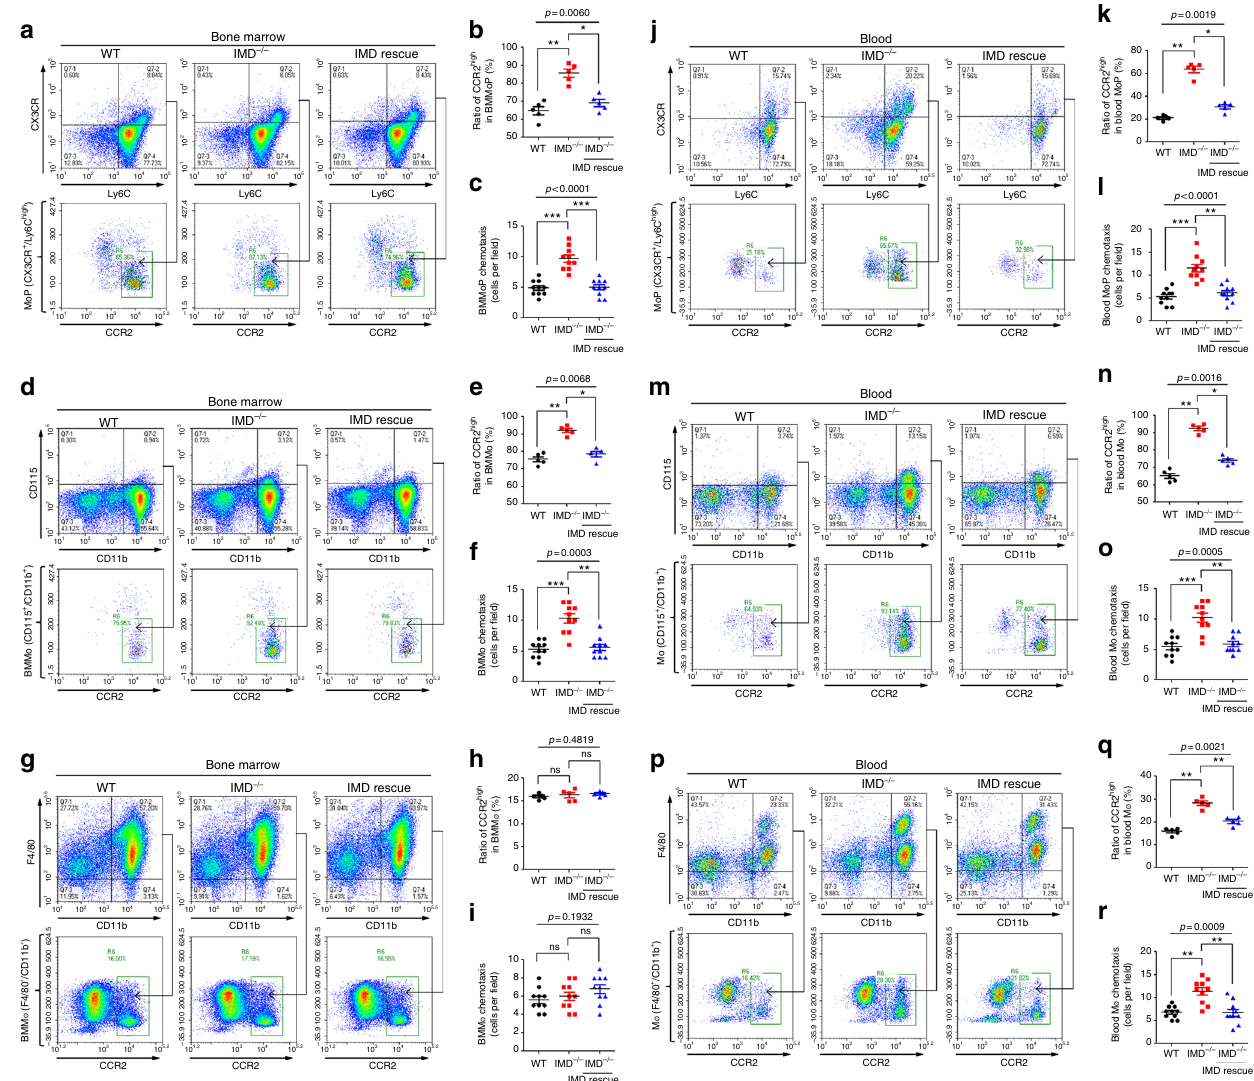
Fig. 5 IMD suppressed the recruitment of macrophages from bone marrow to the periphery via decreasing CCR2 high cells. The bone marrow samples ( a , d , g ) and blood samples ( j , m , p ) from WT, IMD − / − , or IMD − / − mice rescued by IMD 40 injection were analyzed using fl ow cytometry. Gating strategy: monocyte progenitors (MoP, identi fi ed as Ly6C high /CX3CR + ); monocytes (Mo, identi fi ed as CD115 + /CD11b + ); macrophages (M ϕ , identi fi ed as F4-80 + /CD11b + ). Ratio of CCR2 high (%) in BMMoP ( b ), BMMo ( e ), BMM ϕ ( h ), blood MoP ( k ), blood Mo ( n ), and blood M ϕ ( q ) were quanti fi ed. The chemotaxis toward MCP-1 (CCL2) of the BMMoP ( c ), BMMo ( f ), BMM ϕ ( i ), blood MoP ( l ), blood Mo ( o ), and blood M ϕ ( r ) were tested and quanti fi ed. Signi fi cance was assessed by Kruskal – Wallis test followed by non-parametric Dunn ’ s post-hoc